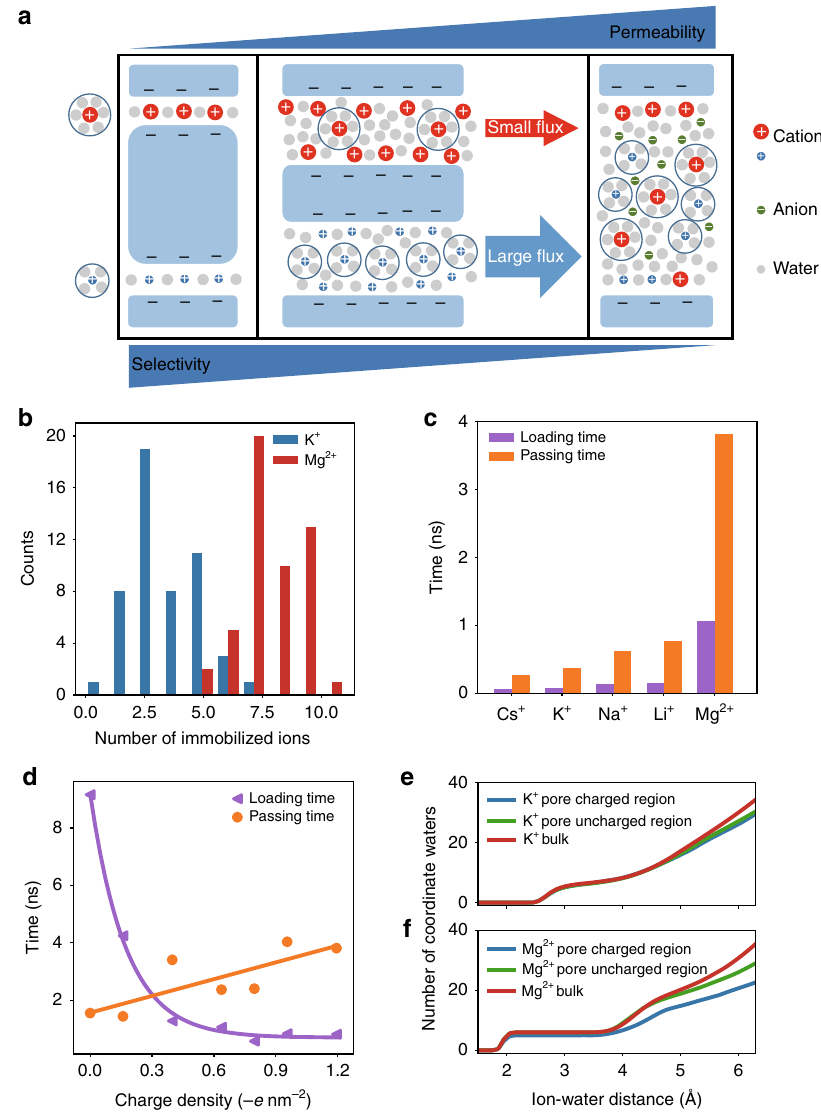
Fig. 3 Simulated ionic transport phenomena. a Schematic of three representative ionic transport mechanisms as the pore size increases in nanopores with negatively charged sidewalls (blue). When the pore size is less than the hydration radius of the cations, the dehydration energy determines the ionic selectivity. The nanopore shows great selectivity but low permeability (left panel). As the pore size is much larger than the Debye screening length, the nanopore shows great permeability but no ionic selectivity (right panel). When the pore size is between the two cases, the nanopore shows high transport rate of one cation and high selectivity between the two cations if their interaction with the pore surface is different (middle panel). This represents the scenario of the transport mechanism of the nanoporous Lumirror® fi lms. b Histogram of immobilized K + (blue) and Mg 2+ (red) ions on the inner surface of the nanometer pore. c Average loading time (purple) and passing time (orange) for Cs + , K + , Na + , Li + , and Mg 2+ ions. d Average loading time (purple) and passing time (orange) of K + ions as a function of surface charge density of the nanopores. Dashed lines are the respective linear and exponential fi ts of the passing and loading times. e , f Cumulative radial distribution function of water molecules surrounding K + ions ( e ) and Mg 2+ ( f ) in the bulk solution (red), inside the nanopore close to the uncharged region (green) without negative inner surface charges or charged region (blue) with negative inner surface charges and trapped